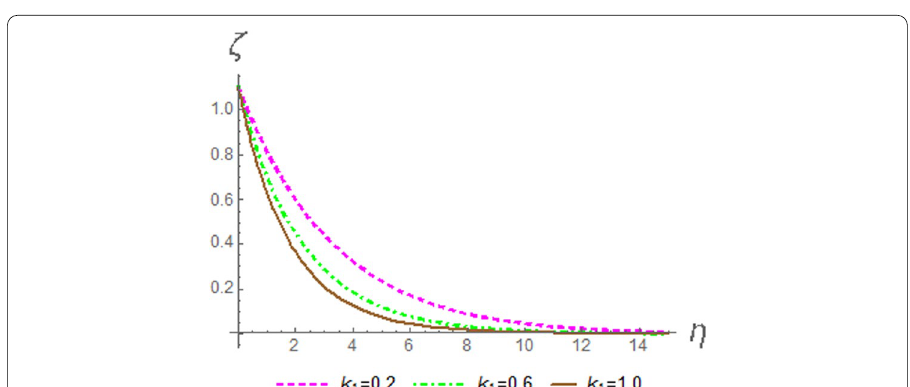
Fig. 7 Effect of k 1 on the concentration